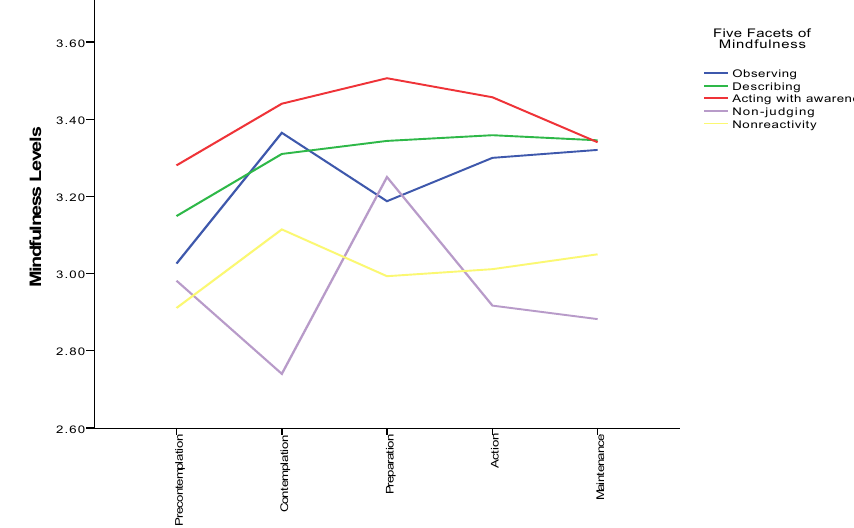
Figure 5. Subscales mindfulness and houseplants care behaviour. Post hoc tests indicated that levels of observing in the pre-contemplation group were significantly different; it decreased from pre-contemplation to preparation, and then in- creased to action ( p = 0.04) and maintenance ( p < 0.01) groups; contemplation and prepa- ration groups were not significantly distinct from other groups on observing scores.